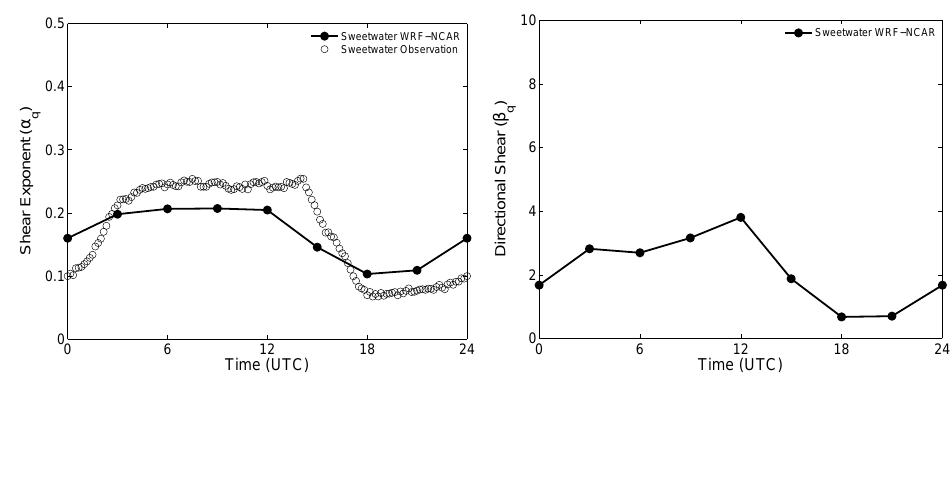
Figure 6. Diurnal variation of the observed and the WRF-NCAR model forecast-derived annual average wind shear exponents (left panel) and the directional shear magnitudes (right panel) at Sweetwater, TX. Study period: April 2006–March